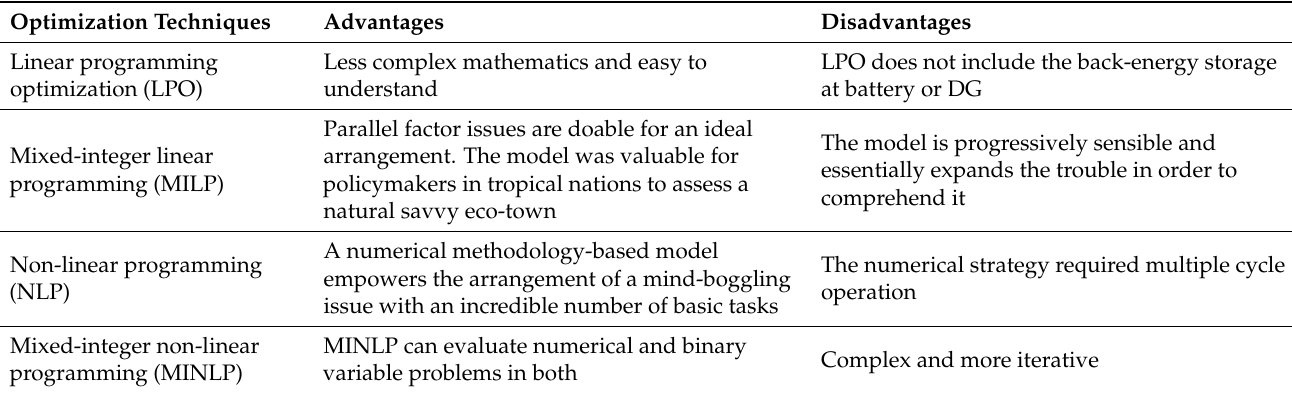
Table 5. Advantages and disadvantages of various types of deterministic methods on the optimization of IHMS